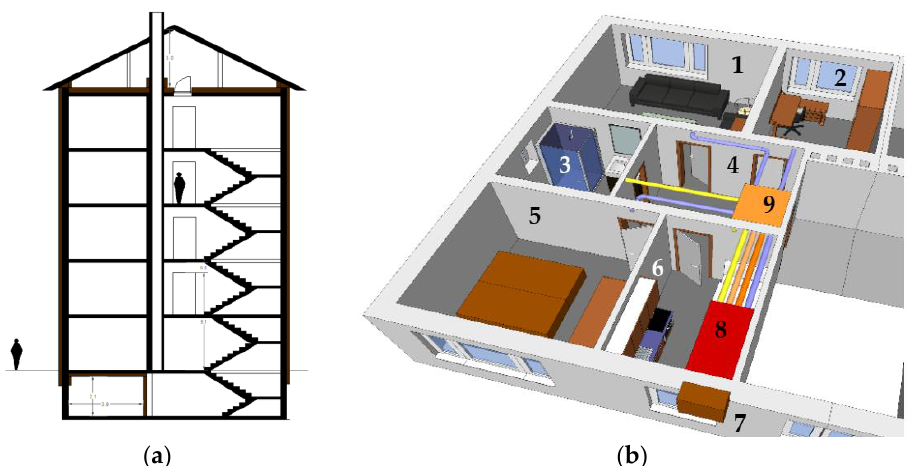
Figure 10. Side view of the multi-apartment building ( a ) with 10 flats (2 symmetrical flats in each store) and a reference flat ( b ) with (1) living room (LI), (2) child room (CH), (3) bathroom (BA), (4) corridor (CO), (5) sleeping room (SL), (6) kitchen (KI), as well as (7) façade-integrated outdoor unit; (8) ceiling mounted indoor unit, and (9) air distribution box.